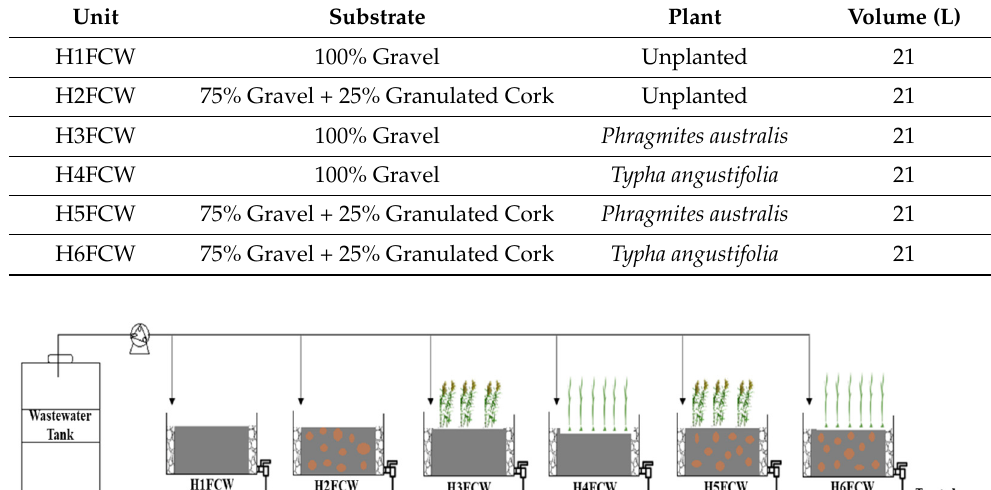
Table 2. Main configurations of the horizontal flow constructed wetlands (HFCWs).